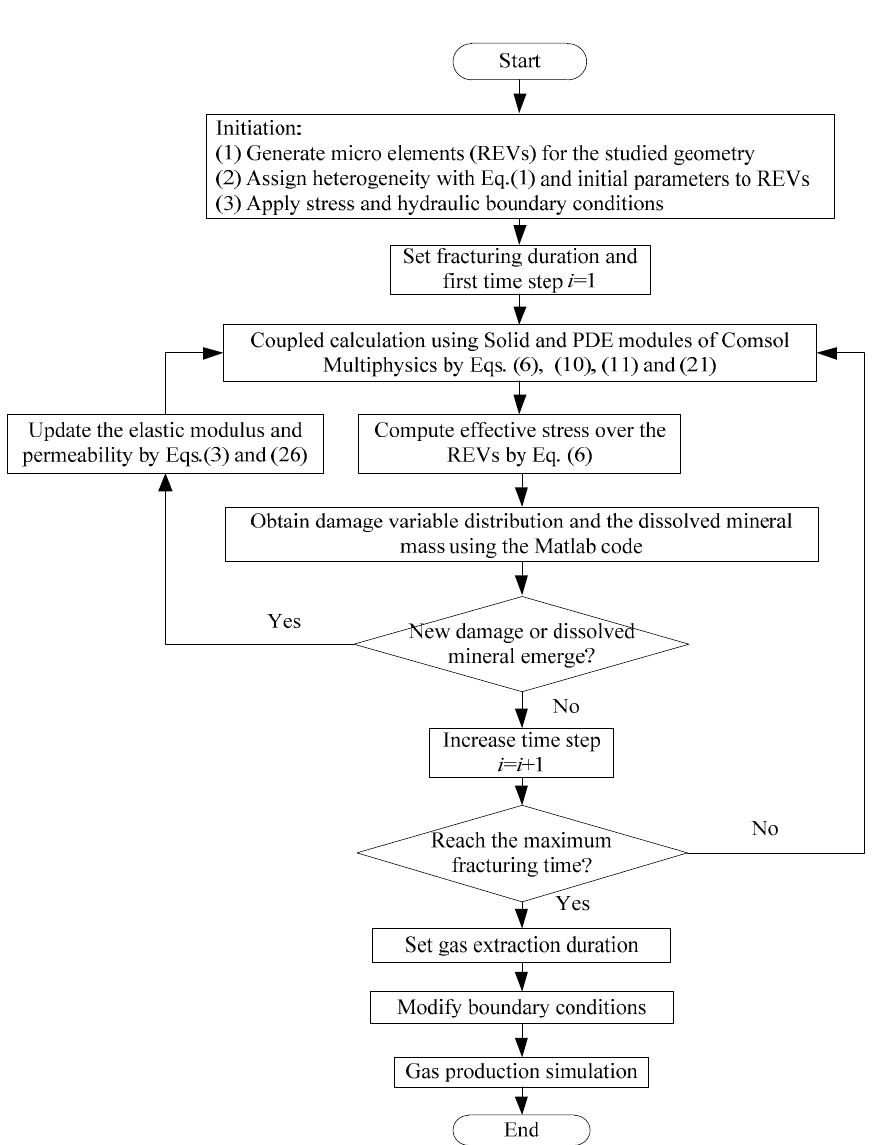
Figure 4. Solving process of the THMC coupled model for acid fracturing enhanced CBM recovery.